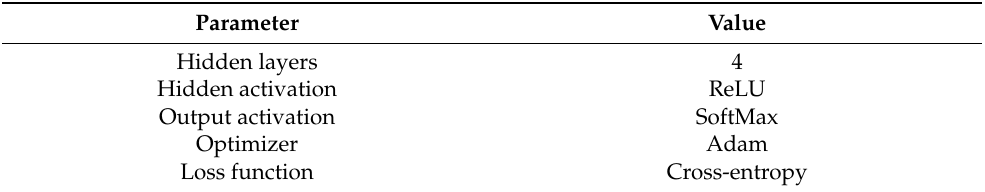
Table 1. Parameters for 1D CNN